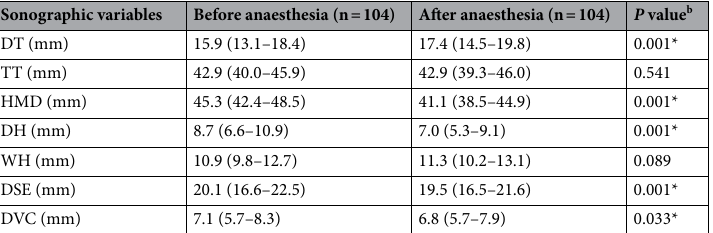
Table 3. Sonographic variables before and after anaesthesia induction and pair wise comparisons. DT distance from skin to under surface of tongue, TT thickness of the thickest part of tongue body, HMD hyoid mental distance, DH depth of hyoid, WH width of hyoid, DSE distance from skin to epiglottis, DVC depth of the anterior combination of the vocal cords. Data are shown as the median ( P 25 –P 75 ) deviation. All data were analyzed by Wilcoxon rank test, * P value <